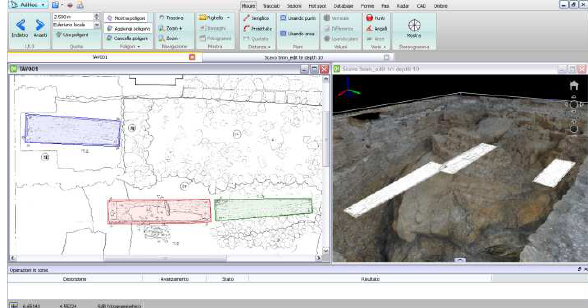
Figure 6. Handmade drawing integrated in 3d point cloud